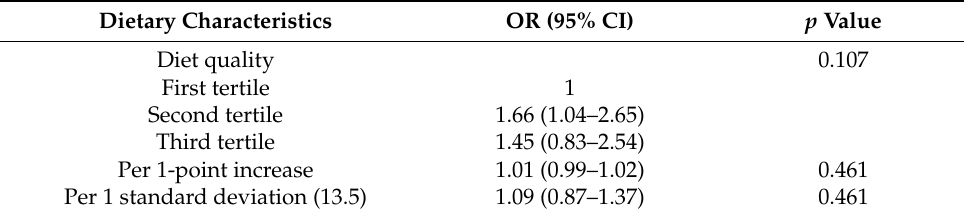
* Adjusted for maternal age, race, parity, family history of diabetes, energy intake, physical activity, time to delivery, and prepregnancy BMI. † CARDIA a priori Diet Quality score (APDQS) rated 0–132, with 0 as lowest quality and 132 as highest quality